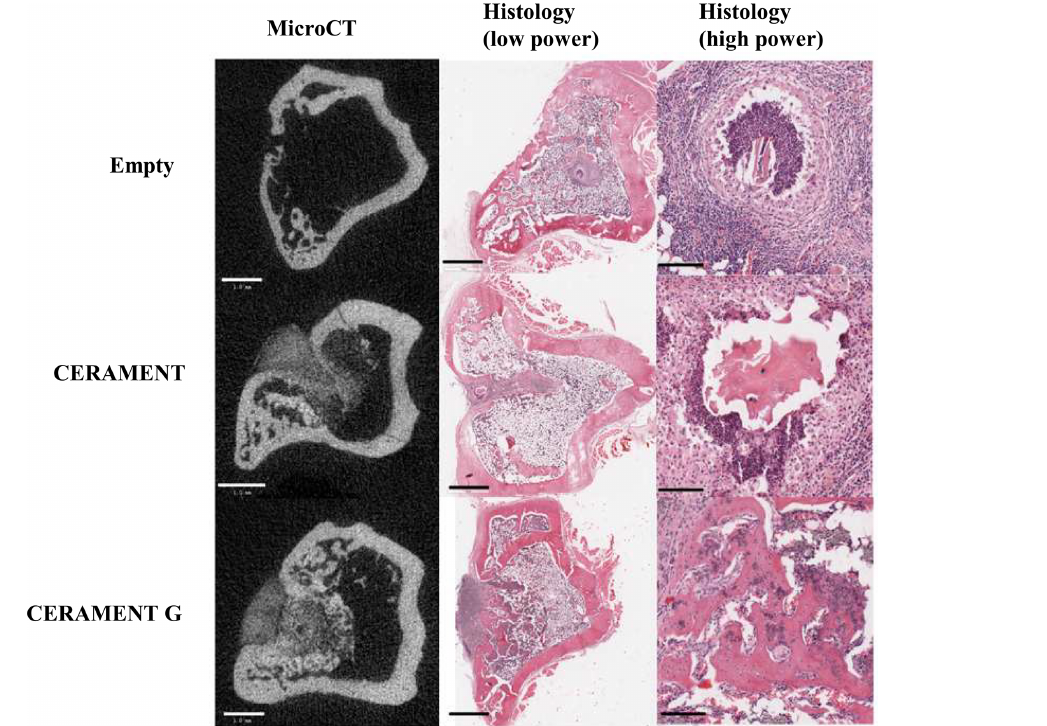
Figure 5. Representative microCT and low/high-magnification H&E sections of representative samples in empty, CERAMENT, and CERA- MENT G groups. MicroCT and low-power images show significant bone growth in the previous defect in CERAMENT and CERAMENT G groups. High-power histology images show evidence of persistent osteomyelitis in the empty and CERAMENT groups as evidenced by a neutrophil predominant infiltrate and necrotic bone with empty lacunae. No such reaction is seen in the CERAMENT G group. Scale bars on the bottom left show 1mm in microCT and low-magnification histology. Scale bars in high-magnification histology show